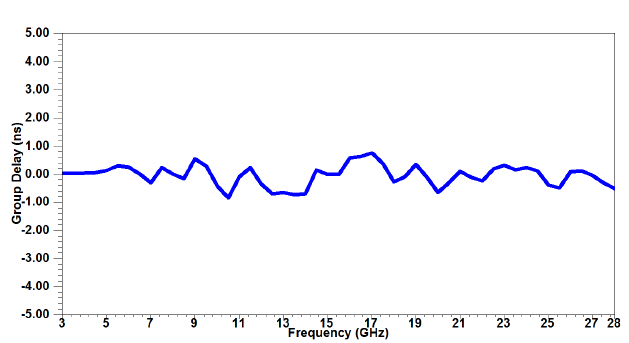
Figure 12: Simulated group delay of proposed DRA